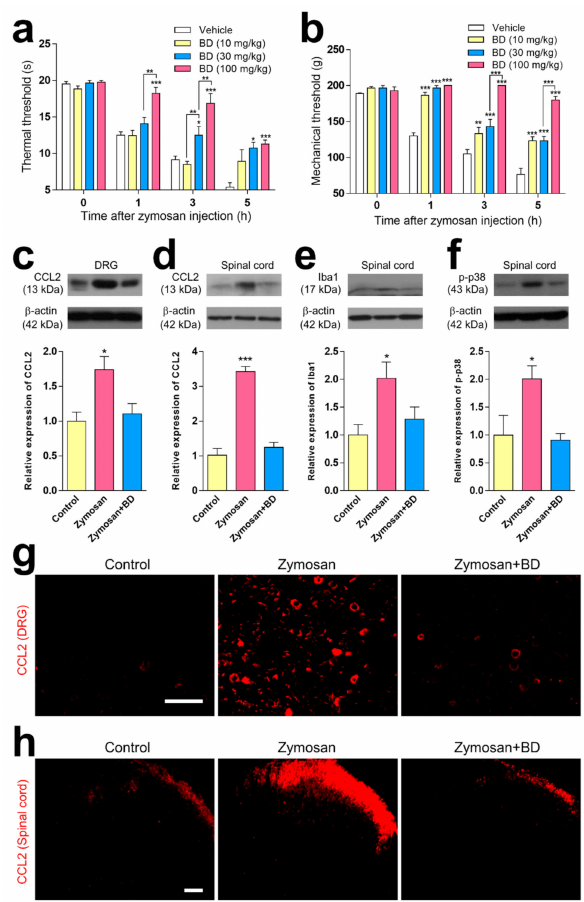
Figure 2. The effect of BD1047 (BD) on zymosan-induced hyperalgesia, and changes in CCL2 el- evation and microglial activation. ( a , b ) Oral pre-treatment of BD at 1 h before zymosan injection dose-dependently reduces thermal hyperalgesia ( a ) and mechanical hyperalgesia ( b ) as compared with vehicle group. * p < 0.05, ** p < 0.01, *** p < 0.001 (compared with vehicle control group at each time-point; n = six rats in each group; data represent the mean ± SEM; Bonferroni’s multiple compar- ison test). The inhibitory effect of BD (100 mg/kg) on zymosan-induced CCL2 immunoreactivity in both dorsal root ganglion (DRG) ( c ); Western blotting using four rats, ( g ); immunohistochemistry using three rats) and spinal dorsal horn ( d ); Western blotting using four rats, ( h ); immunohistochem- istry using three rats). The inhibitory effect of BD on zymosan-induced microglia proliferation ( e ) and phosphorylated p38 mitogen-activated protein kinase (p-p38) expression in spinal dorsal horn ( f ) compared with a non-inflamed control group. Scale bar = 100 µ m. * p < 0.05, *** p < 0.001 (compared from non-inflamed control group; n = three rats in each group; data represent the mean ± SEM; Tukey’s multiple comparison